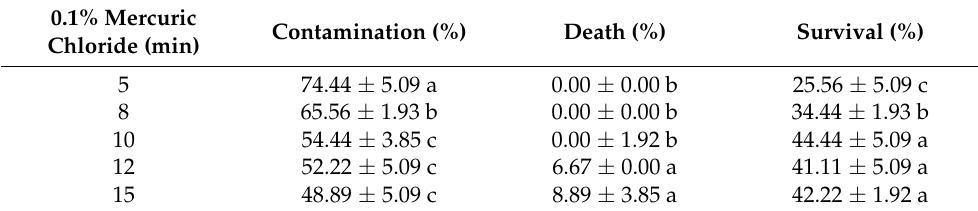
Table 1. Effect of 0.1% mercuric chloride on explant sterilization.